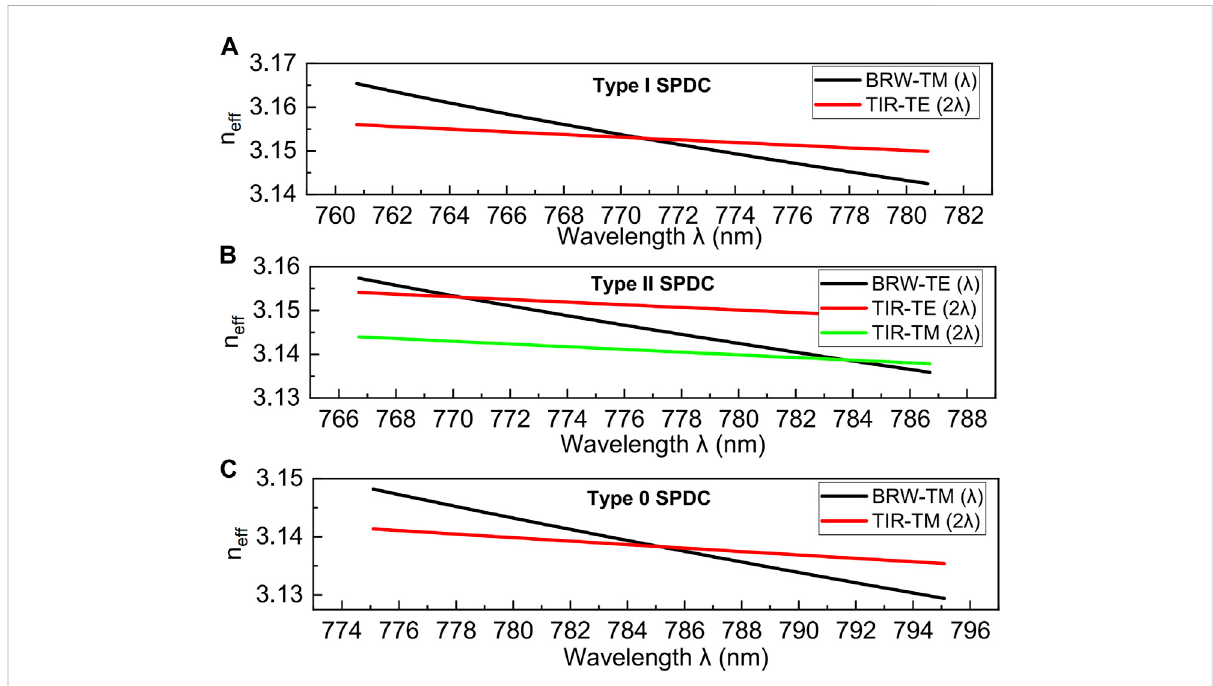
FIGURE 2 Dispersion curves of BRW and TIR modes for three parametric processes: Type-I (A) , Type-II (B) and Type-0 (C) .